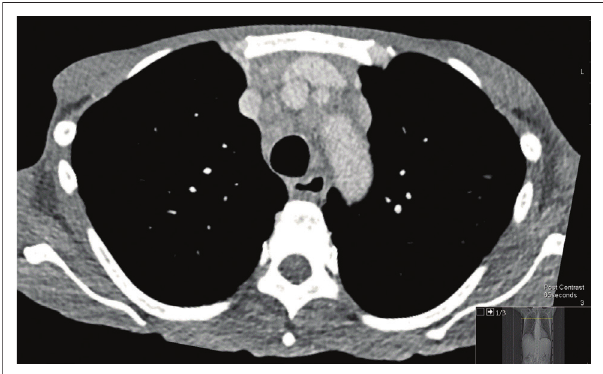
FIGURE 5: Anterior mediastinal lymph